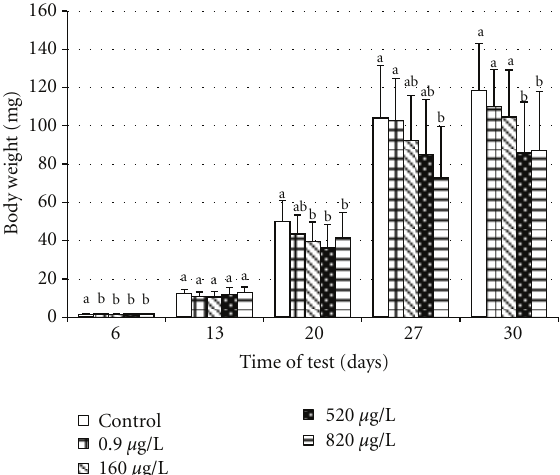
Figure 2: Body weight of common carp during the embryolarval toxicity test (mean ± SD; (a, b) groups with di ff erent alphabetic superscripts di ff er significantly ( P < 0 . 05); day 6, 13, and 27 n = 75; day 20 n = 150; day 30 n =